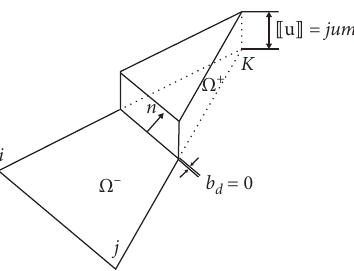
Figure 6: Constant strain triangle with a displacement jump.